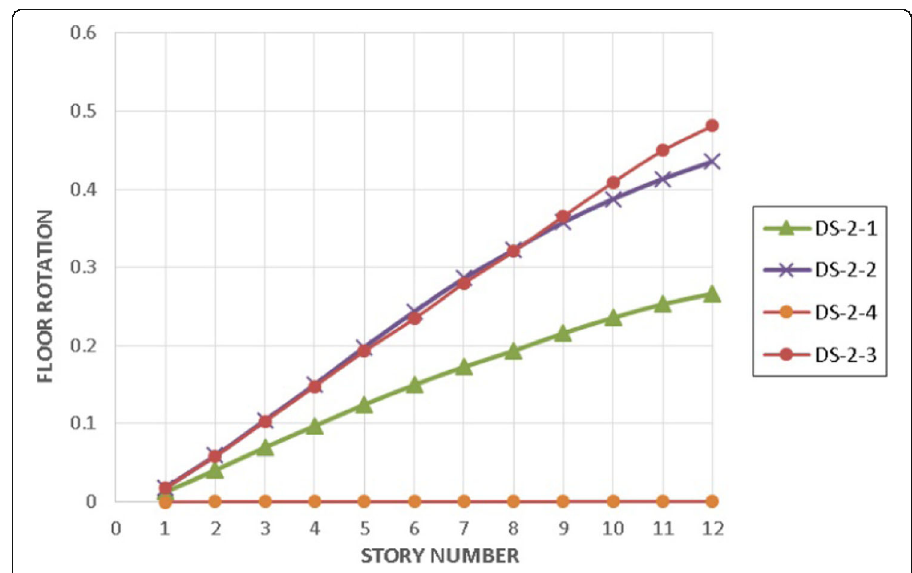
Fig. 33 Comparison of floor rotations — floor number for (DS-2-1, DS-2-2, DS-2-3, and DS-2-4)